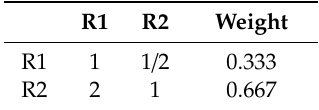
Table A2. Pairwise comparison matrix of urban resources indicators.